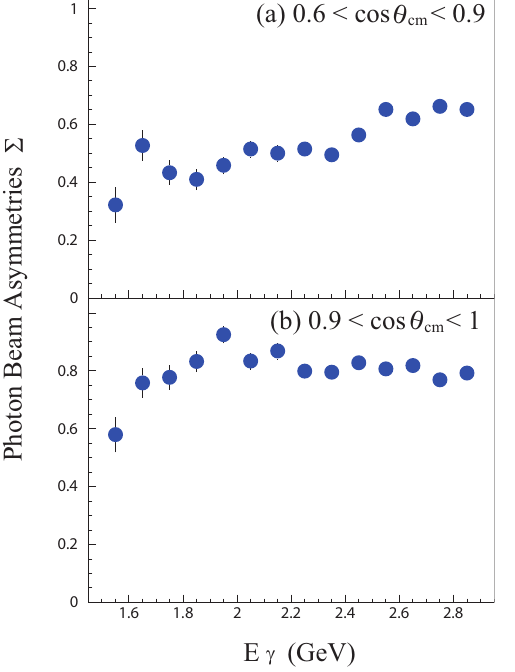
Figure 2. Photon beam asymmetries for the ~γ p → π + n reaction for (a) 0.6 < cos θ cm < 0.9 and (b) 0.9 < cos θ cm < 1 [22].